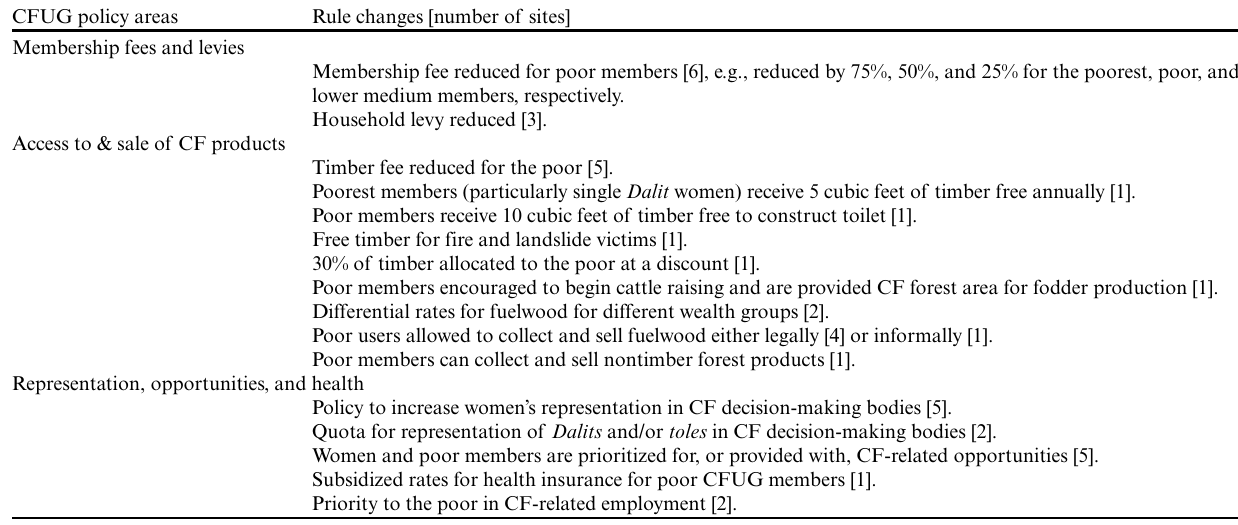
Table 2 . Changes in community forest user group (CFUG) rules and norms affecting distributional equity (n = 11). Notes: Changes between pre- and with-adaptive collaborative governance (2004-2007). CF = community forestry. Sources: CFUG executive committee and general assembly records, key informant